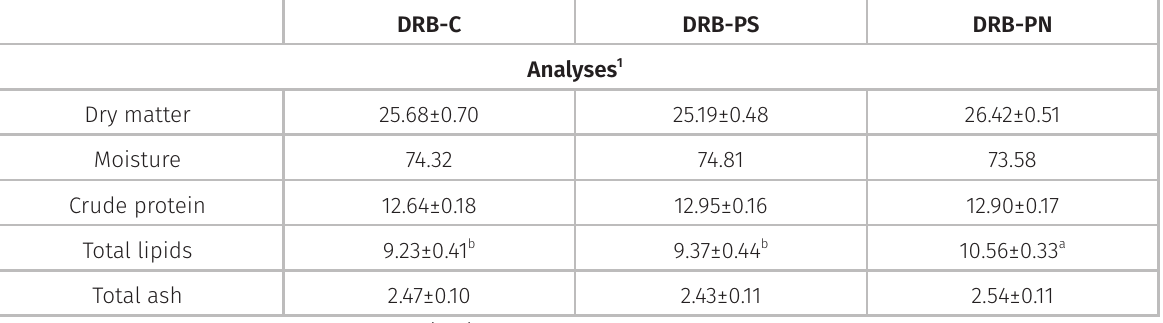
Table IV. Proximate chemical composition of whole body (% on fresh weight basis) of juvenile grass carp ( Ctnopharyngodon idella ) fed on diets with different phytase